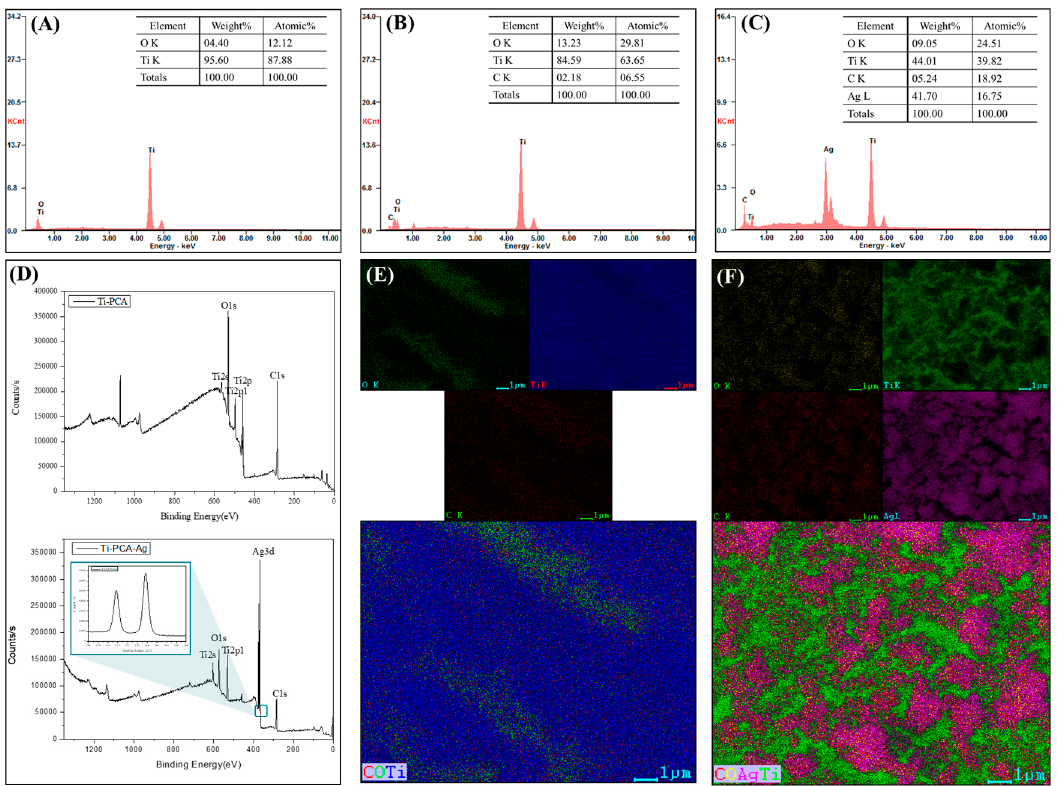
Figure 3. Energy dispersive X-ray spectroscopy (EDS) spectra showing the main components present on the surface of ( A ) Etched Ti, ( B ) Ti–PCA, and ( C ) Ti–PCA–Ag. ( D ) XPS spectra of the Ti–CA ( upper ) and Ti–PCA–Ag ( below ) (inset: XPS spectra Ag3d scan). Mapping of the elemental species on the surface of ( E ) Ti–PCA and ( F ) Ti–PCA–Ag.